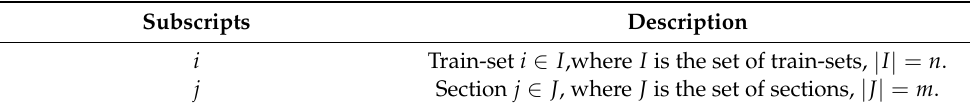
Table 1. General subscripts.